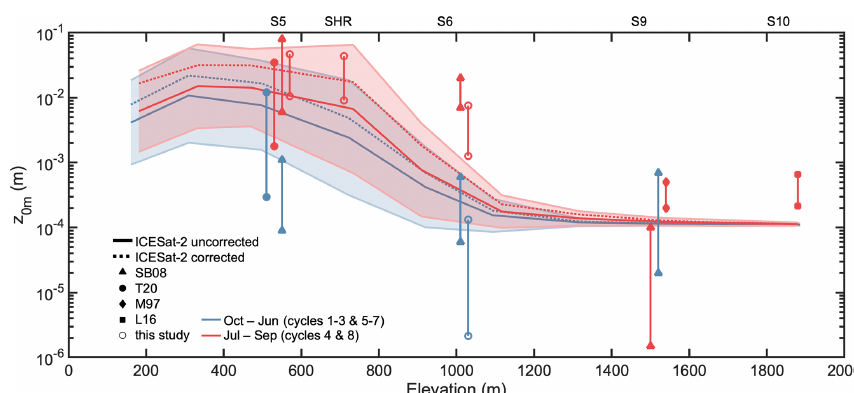
Figure 10. Estimated aerodynamic roughness length ( z 0m ) from ICESat-2 between 16 October 2018 until 6 September 2020 along the K- transect. The data were averaged over 200m elevation bins and two time periods: summer (July–September) and winter (October–June). The variability range denotes the two-sided standard deviation within one elevation class. The in situ observations are described in Table